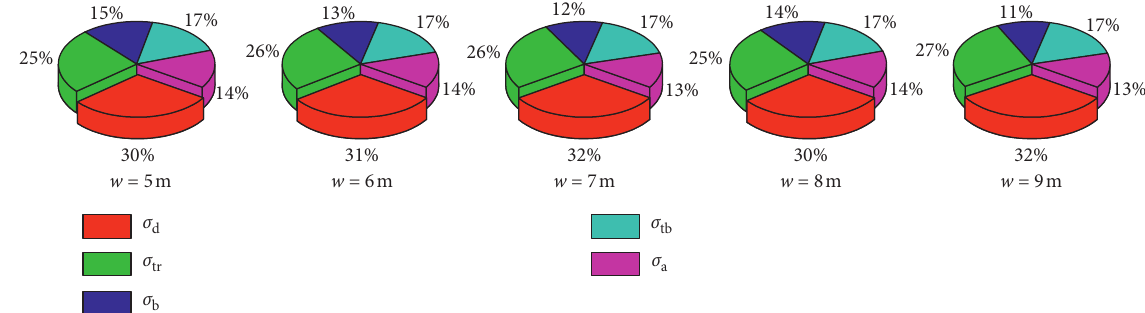
Figure 7: Proportions of different stress among total stress.